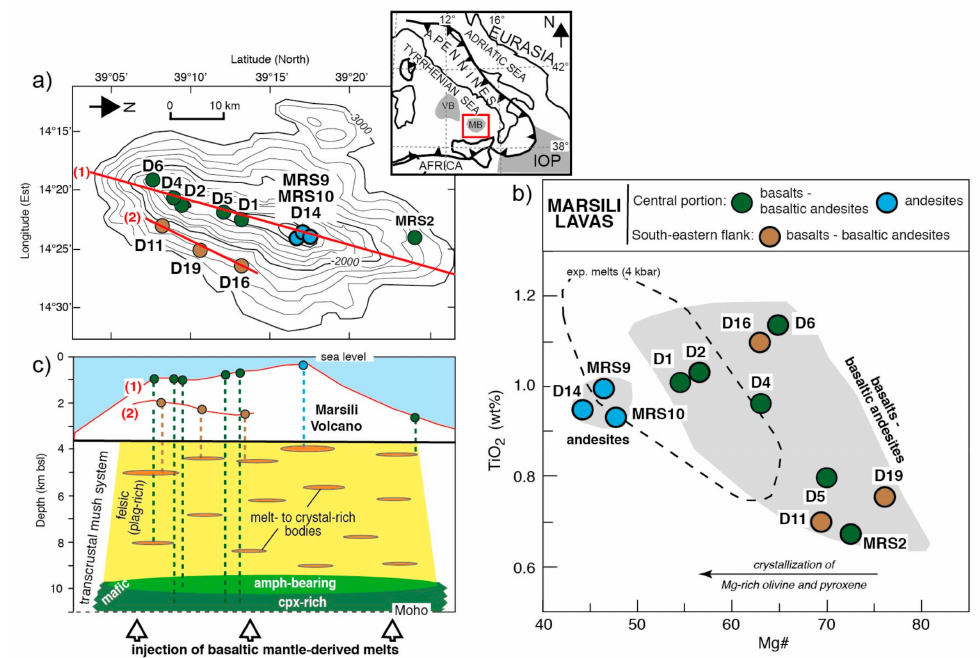
Figure 1. ( a ) Bathymetry of the Marsili Volcano (MV) back-arc spreading centre (contour interval 200 m)—the location is the red box in the inset. Coloured circles indicate the location of the studied lava samples: the central portion lavas are in greenor in light blue in function of the composition; the south-eastern volcano flank lavas are in brown. The numbered red lines represent the tracks of the crustal section shown in ( c ). The inset shows the locations of the Marsili Basin (MB; red boxed area) and the older Vavilov Basin (VB), the two back-arc basins of the Tyrrhenian Sea. IOP = Ionian Oceanic Plate. ( b ) TiO 2 content versus Mg# value for the Marsili lavas (grey fields). Lava samples are named and marked with the colour-coded circles of ( a ): green for basalts and basaltic andesites, light blue for andesites in the central portion, and brown for basalts and basaltic andesites from the south-eastern flank. The black dashed line refers to a field of glasses obtained by low pressure (4 kbar) crystallization experiments simulating chemical evolution of arc-like magmas [8,10]. ( c ) Cross section of the transcrustal system beneath the Marsili Volcano back-arc spreading centre [18]. For each lava, the crustal storage level, given as depth below sea level (bsl), is based on the results of plagioclase barometric modelling [18] reported in Table 1. Dotted vertical lines, colour-coded as in ( a ), link storage depth to eruptive sites. The petrological data indicate that the feeding system is compositionally layered: its roots are made of domains transitioning from mafic/ultramafic clinopyroxene (cpx)-rich (dark green) to amphibole (amph)-bearing gabbroic (light green), while the mid to shallow portions contain a network of storage zones (ranging from melt-rich to crystals-rich), set into a felsic, plagioclase (plag)-rich